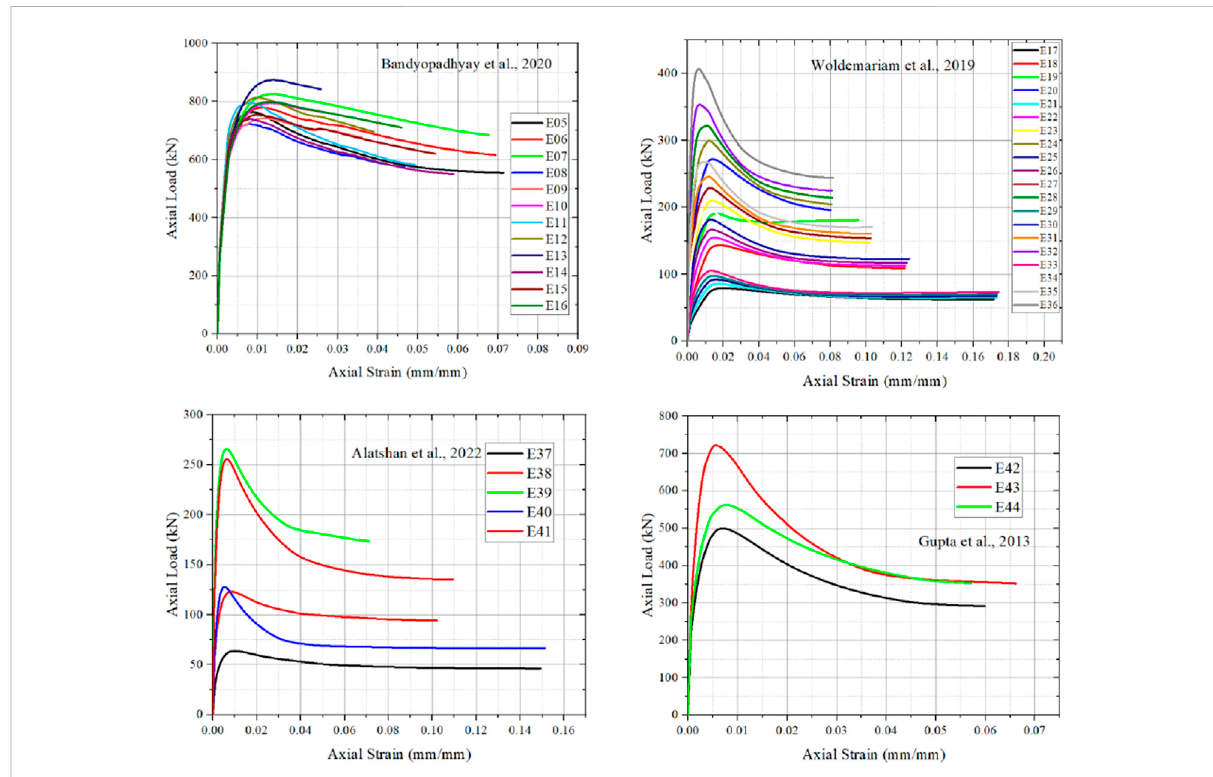
FIGURE 2 Axial stress and axial strain from (Bandyopadhyay et al., 2020; Woldemariam et al., 2019; Alatshan et al., 2022 and Gupta, 2013).